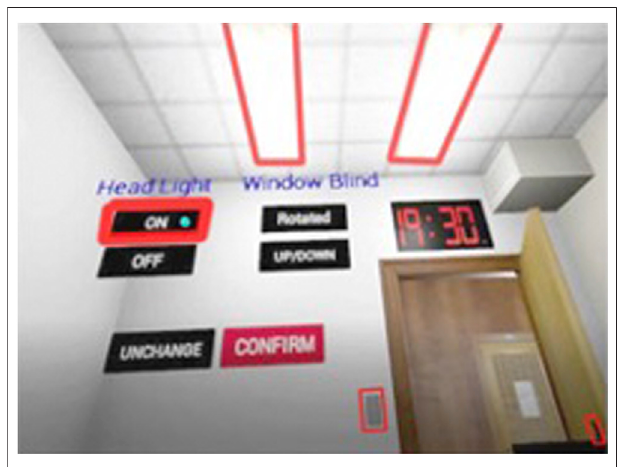
FIGURE 11 | Saeidi et al. (2019) used instructional cues to help participants navigate within the IVE and distinguish and interact with operable virtual